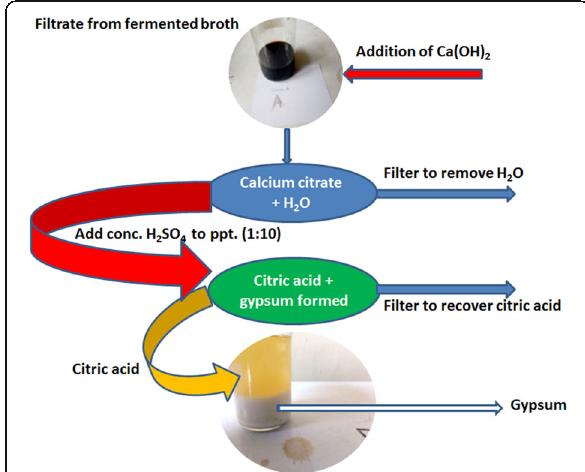
Fig. 3 Scheme for the recovery and purification of citric